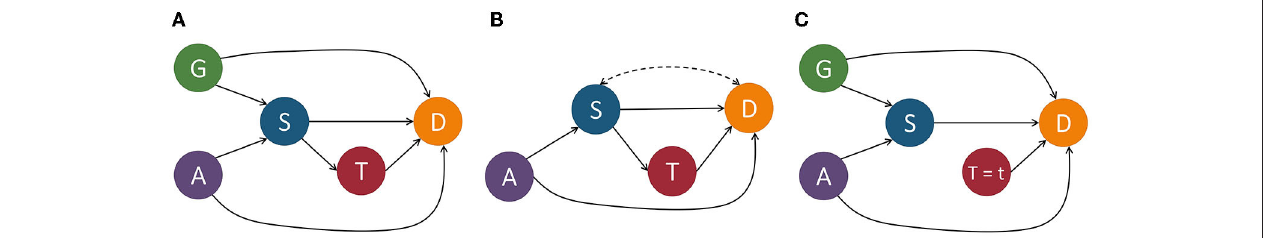
FIGURE 2 | Example of a structural causal model depicting the relationships between variables that determine the survival of some disease. G , gender; A , age; S , severeness; T , treatment; D , survival. In (A) , we include the exogenous variable gender and in (B) we show it removed by adding a bi-directional dashed line between S and D since this is a semi-Markovian model. In (C) , we perform an intervention on variable T by setting it equal to t